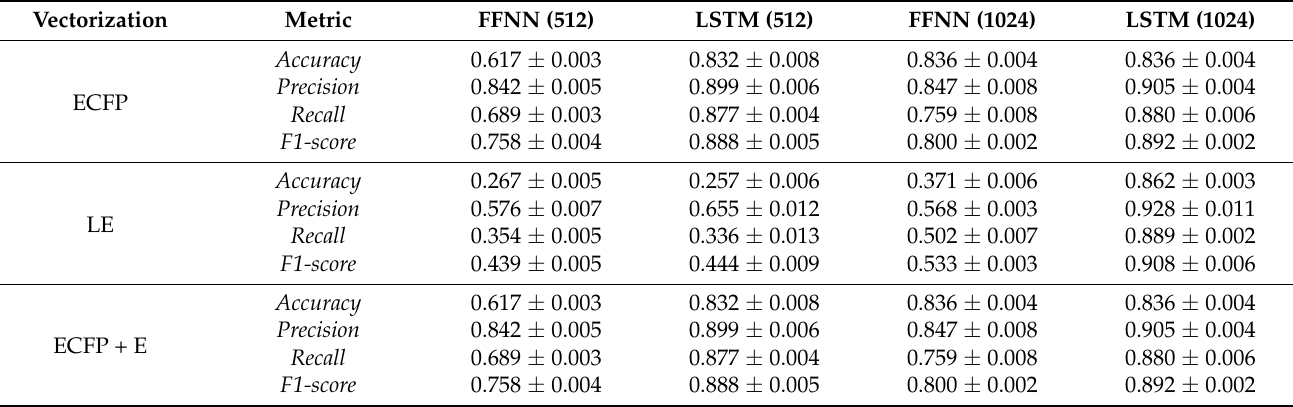
Table 5. Evaluation results on DS2. The lengths of the vectors are presented in